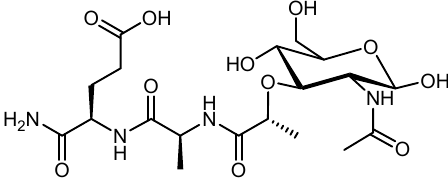
Figure 10. Example of muramyl dipeptide (MDP).